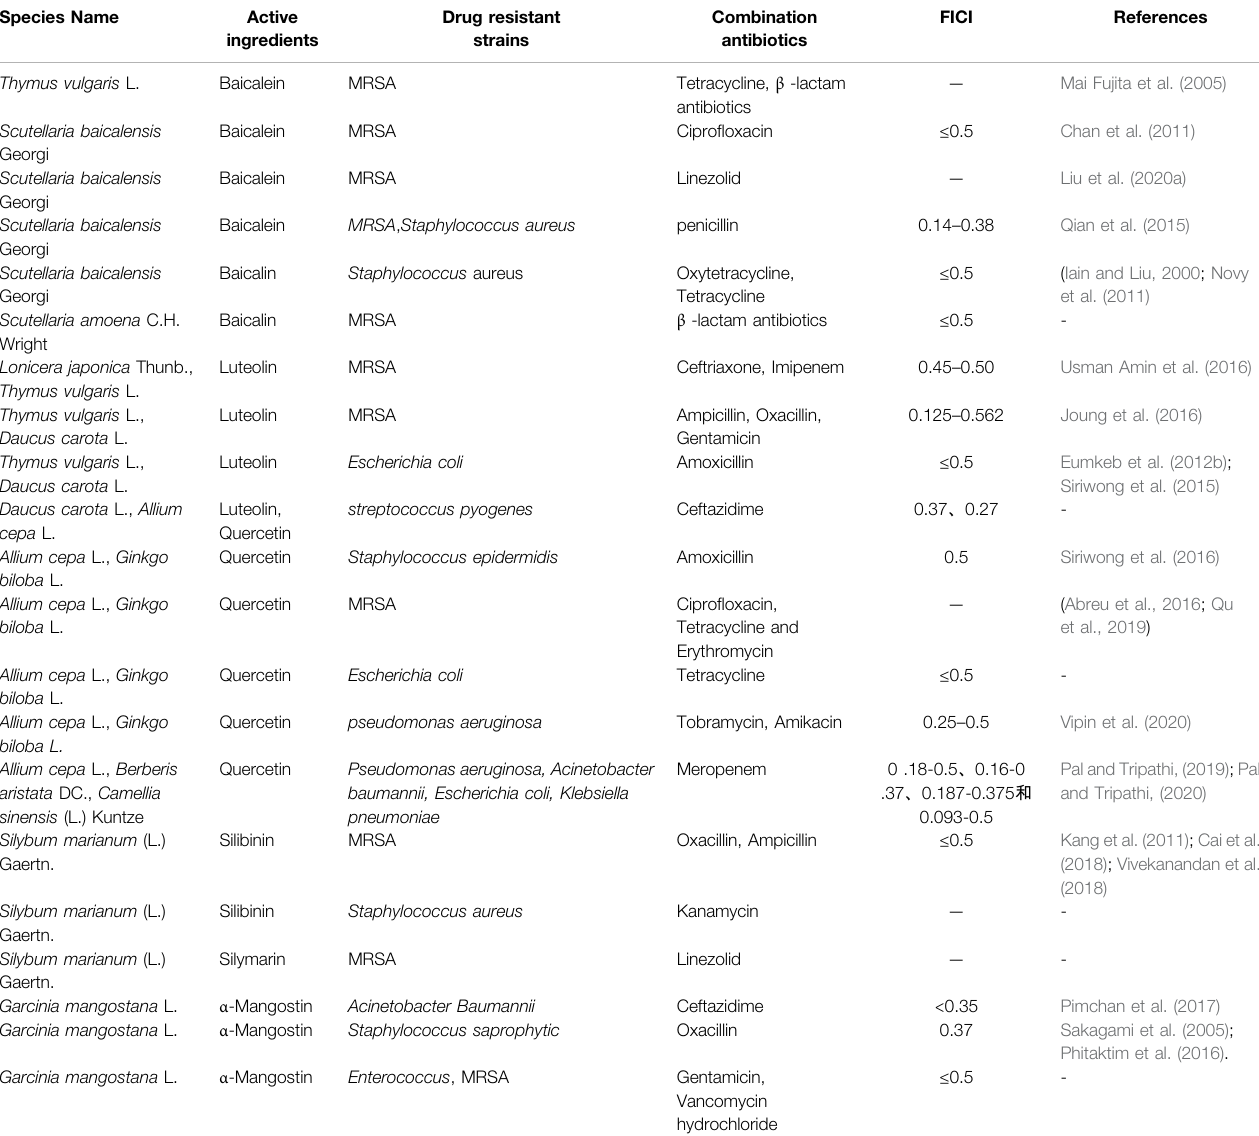
TABLE 1 | Summary of fl avonoids compounds in combination with